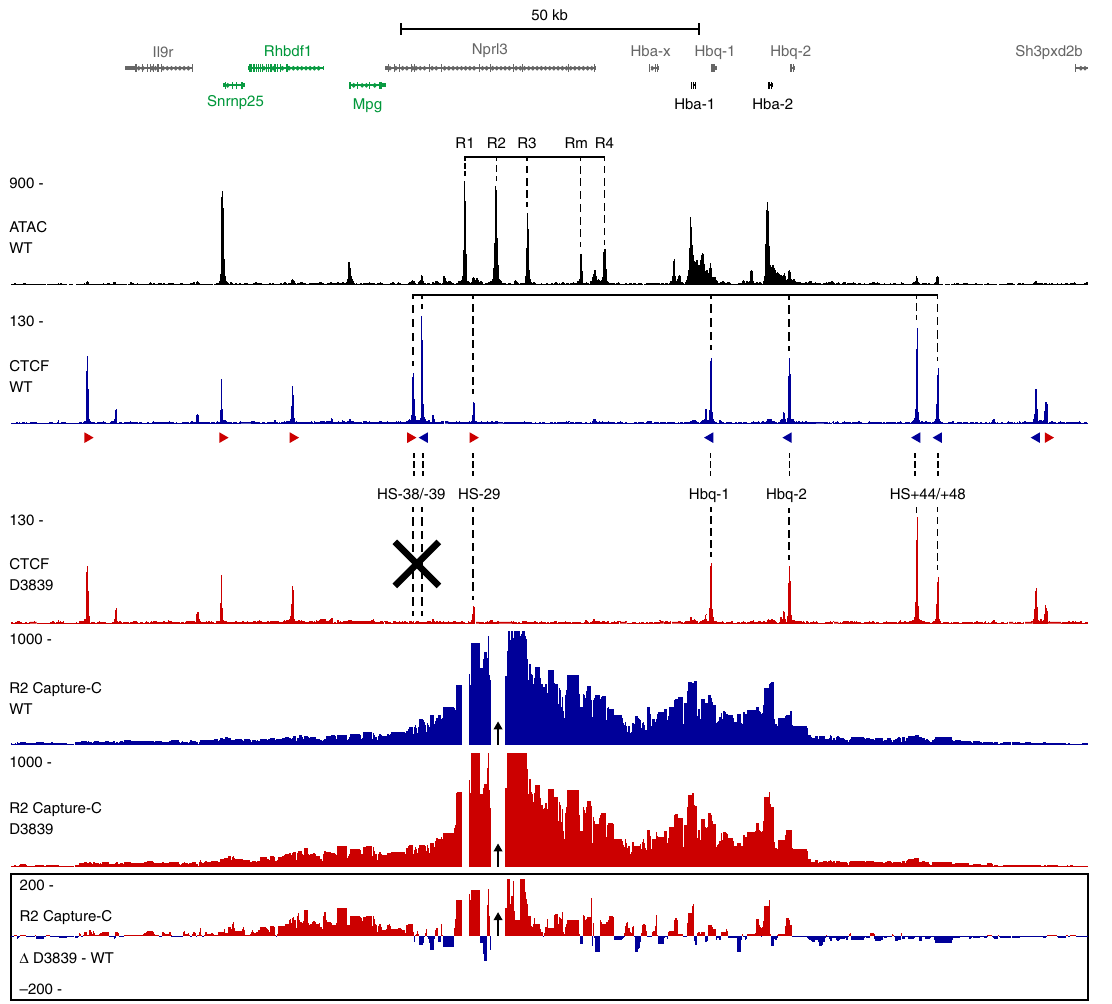
Fig. 1 Characterization of a CTCF boundary deletion upstream of the α -globin locus. Gene annotation is shown at the top, with the α -globin genes in bold and genes upregulated by the CTCF boundary deletion highlighted in green. Open chromatin (ATAC in WT erythroid cells) is shown below, with the α - globin enhancers highlighted. CTCF occupancy in WT (blue) and D3839 (red) erythroid cells is shown underneath, with the orientation of the CTCF- binding motifs indicated by arrowheads (forward orientation in red; reverse orientation in blue). CTCF-binding sites of interest are highlighted and the deleted CTCF-binding sites are indicated with a black cross. The pro fi les below show Capture-C interactions from the viewpoint of the R2 enhancer (indicated with a black arrow) in WT (blue) and D3839 (red) erythroid cells, with a differential pro fi le at the bottom. Pro fi les represent the mean number of normalized unique interaction counts per restriction fragment in n = 3 biological replicates. Coordinates (mm9): chr11:32,070,000 –